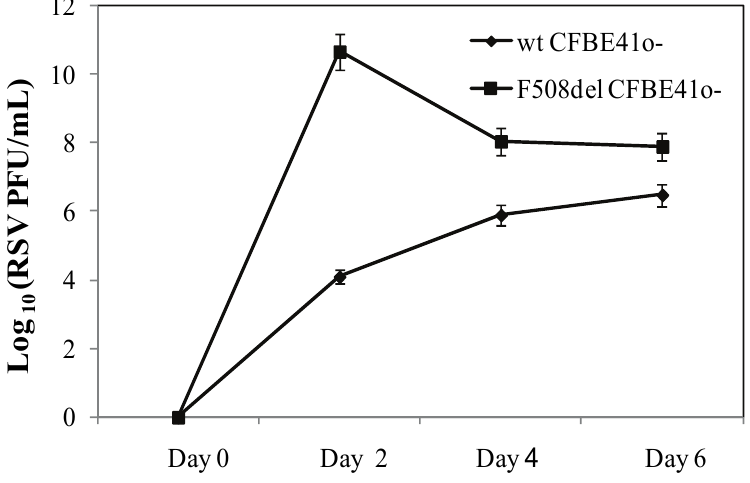
Figure 4. RSV titer in media of F508del and wt CFBE41o- cells with time. CFBE41o- cells transduced to overexpressed F508del (black square) or wt CFTR (black diamond) were inoculated with RSV (MOI = 0.1) at time point 0. Media from both cell lines were collected from the apical compartment at Days 2, 4 and 6 post RSV infection, and used to determine changes in viral load over time.